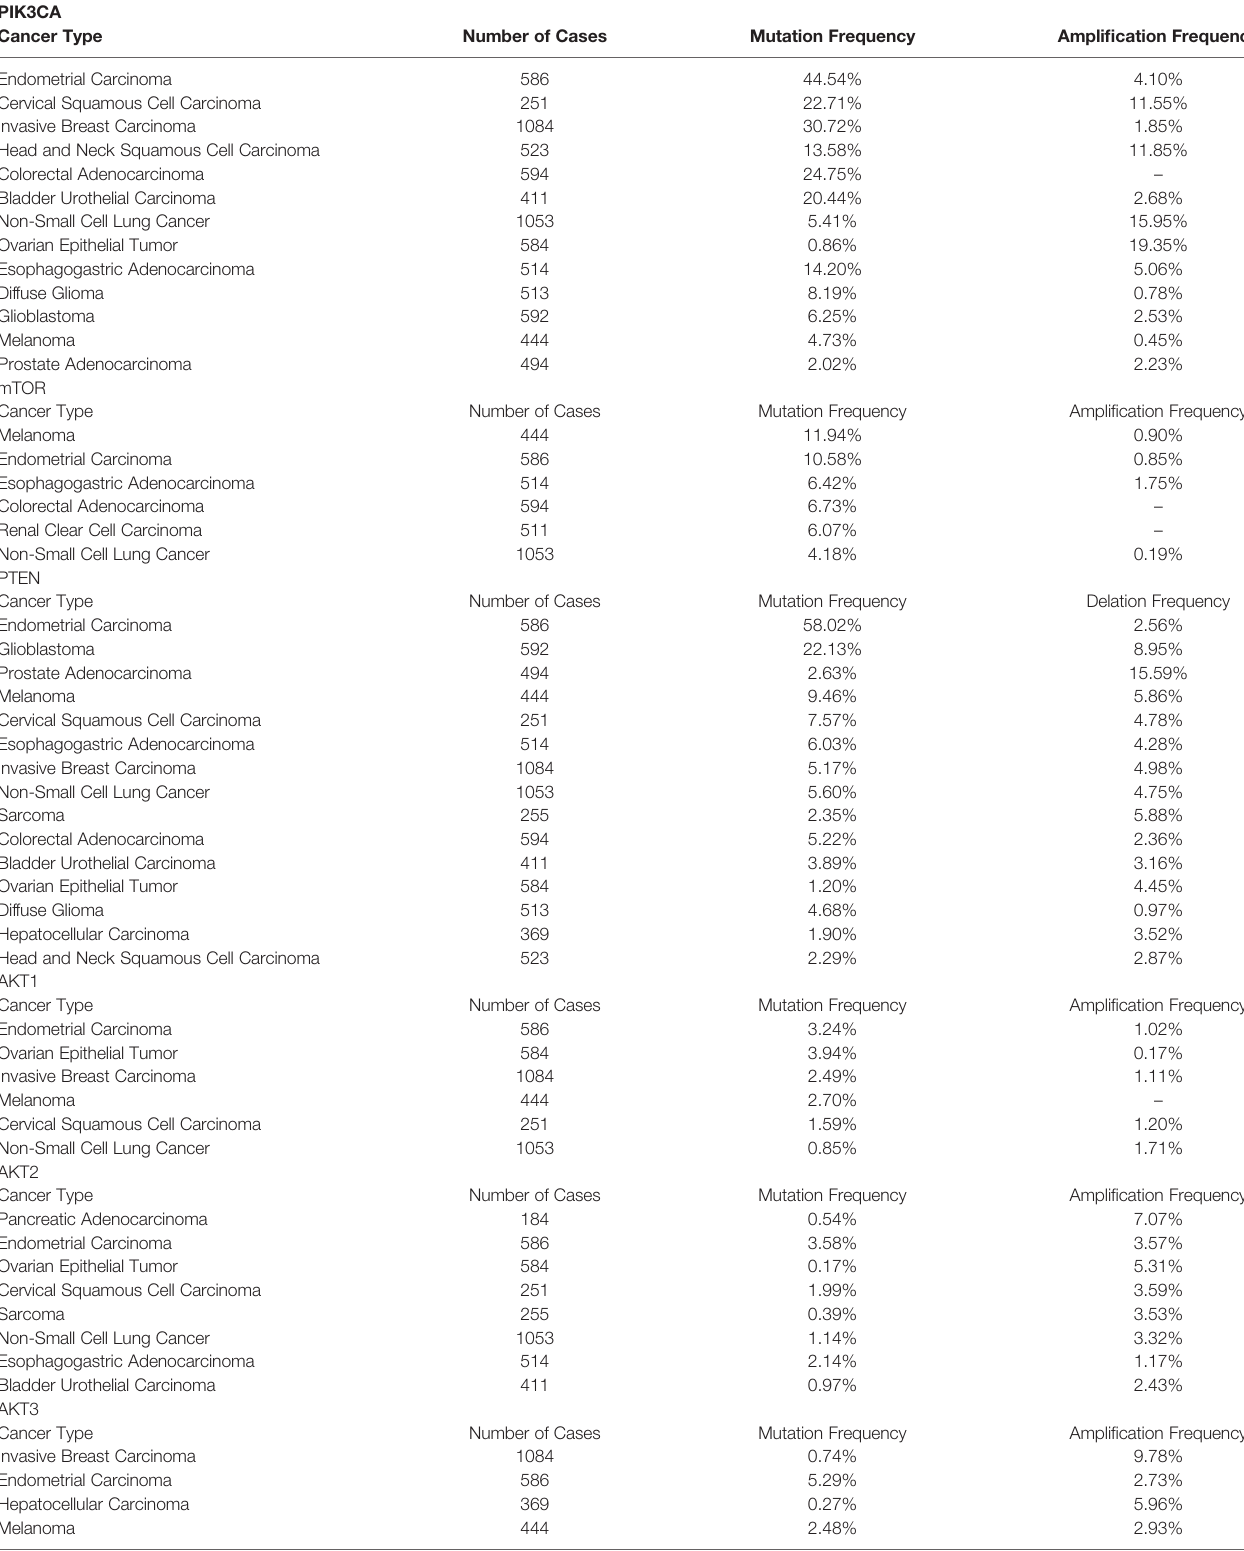
TABLE 2 | Genetic alterations of the PIK3CA, mTOR, PTEN, AKT1, AKT2, and AKT3 genes in human